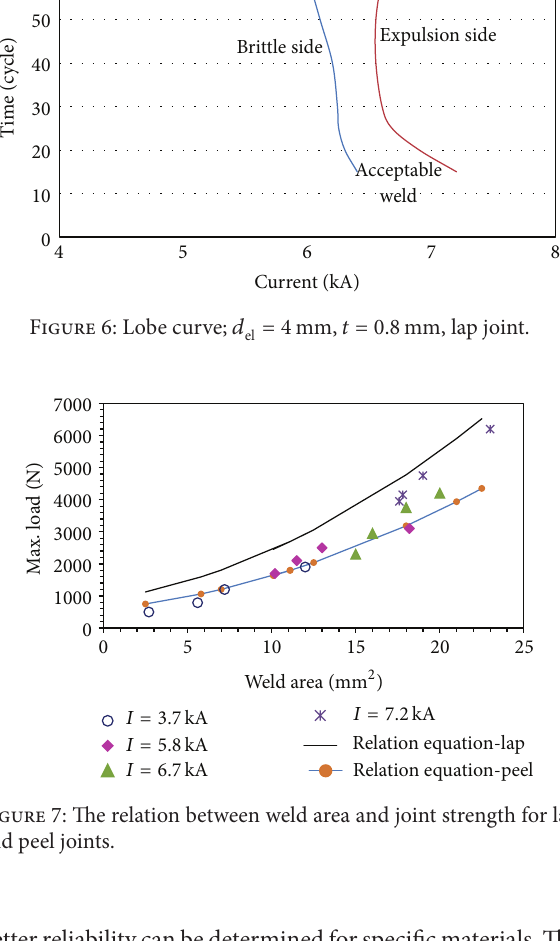
Figure 7: The relation between weld area and joint strength for lap and peel